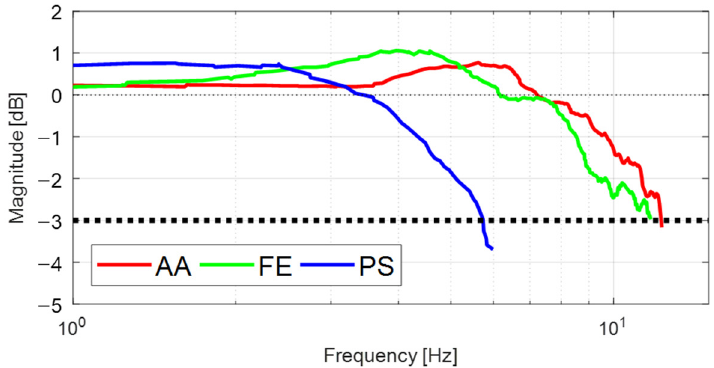
Figure 9. Frequency responses of the proposed device for each DOF from experiment.